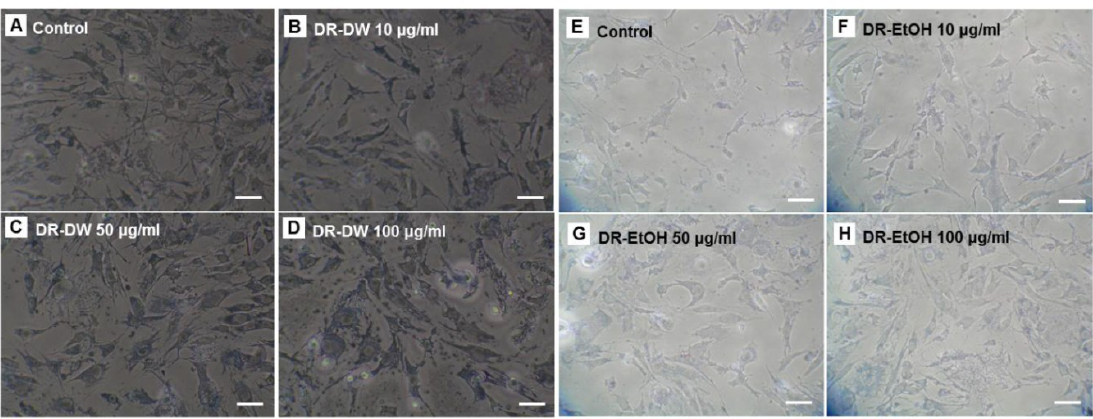
Figure 3. Morphological changes of mouse osteoblastic cells after treatment with various concentrations of DR-DW (A–D) and DR-EtOH (E–H) from Drynariae rhizoma . Scale bar = 20